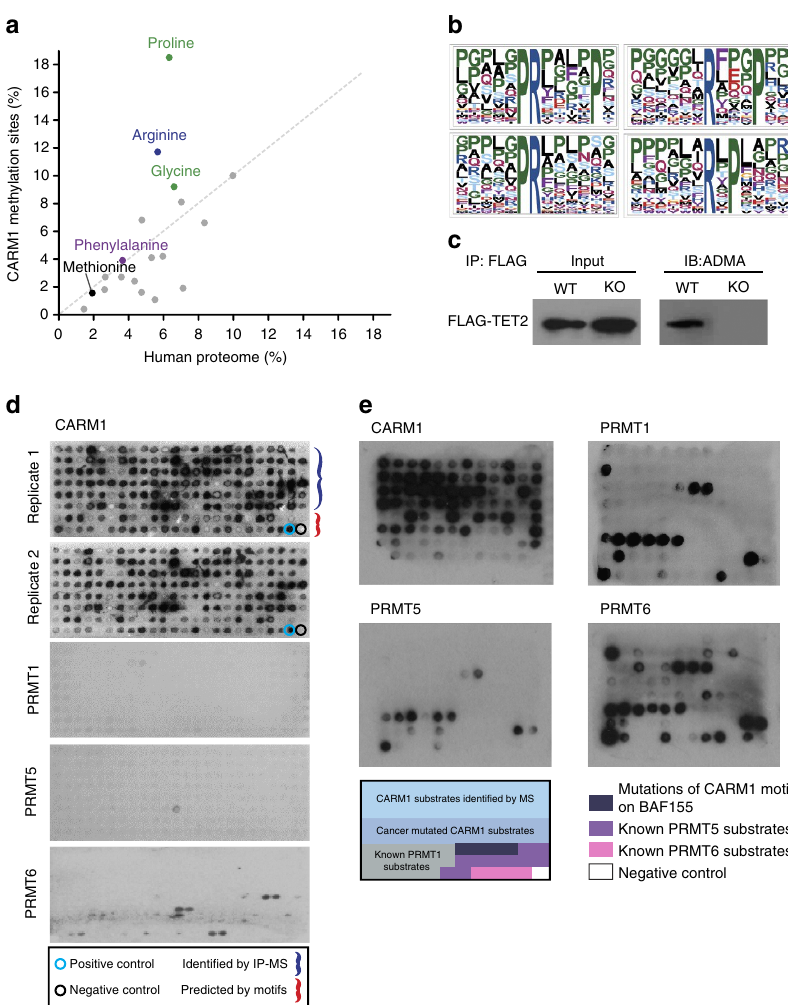
Figure 2 | Discovery of proline-rich CARM1 methylation motifs and high-throughput validation of the detected substrates using peptide arrays. ( a ) Amino-acid abundance analysis of CARM1 methylation sites. Frequencies of amino acids in the vicinity of CARM1-regulated methylation sites ( ± 5 nucleotides) were compared to those in the human proteome, revealing pronounced enrichment of proline residues. Glycine, methionine and phenylalanine residues were detected at frequencies typical of the human proteome ( P value 4 0.01; two-tailed Student’s t -test). ( b ) Sequence logos of CARM1 methylation motifs. Various proline-containing motifs were enriched in the proximity of the detected CARM1 methylation sites. ( c ) Western blot with ADMA antibodies of FLAG-tagged TET2 in wild type and CARM1 KO HEK293T cells showing the reduction of TET2 dimethylation in CARM1 KO. ( d ) Autoradiography of 192-spot peptide arrays following the in vitro methylation assay using 3 H-labelled SAM and indicated purified mammalian PRMTs. The peptide arrays consisted of B 15 amino-acid sequences centred on substrate arginines. Designated by the blue bracket are substrates of CARM1 identified by IP-MS; the red bracket indicates substrates predicted based on the extracted motifs. Positive control (BAF155 peptide) is denoted with a blue circle; negative control (no peptide) is indicated with a black circle. ( e ) Autoradiography of 96-spot peptide arrays following the in vitro methylation assay using 3 H-labelled SAM and indicated purified mammalian PRMTs. The design of peptide array is depicted at the bottom. Light blue colour designates the location of novel, cancer-related substrates of CARM1 identified by IP-MS; blue—additional substrates and their naturally occurring mutations in human cancer; dark-blue—point mutations of the recognition sequence adjacent to the CARM1 methylation site on BAF155; grey—known substrates of PRTM1; purple—known substrates of PRMT5; pink—known substrates of PRMT6; white—negative control (no